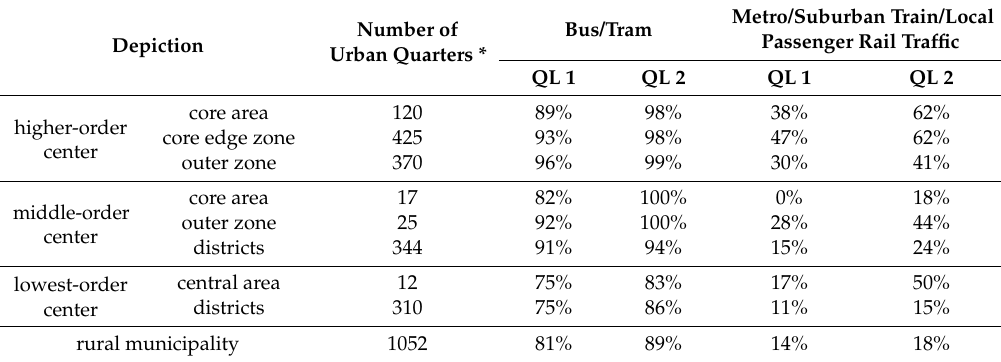
Table 4. Proportionate coverage of settlement area per urban quarter differentiated by accessibility radii according to quality levels and transport mode group in the operating area of the Verkehrsverbund Großraum Nürnberg (VGN) (own depiction).